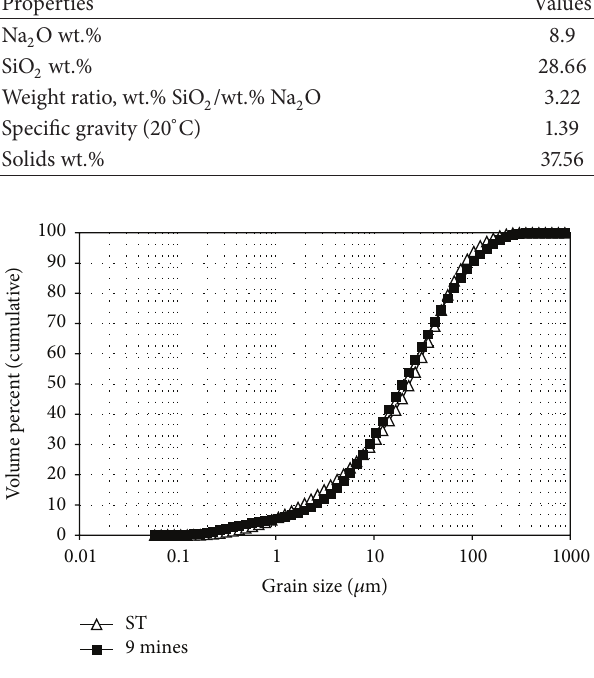
Figure 1: Grain size distribution of STs and the average distribution of tailing grain size from nine Canadian